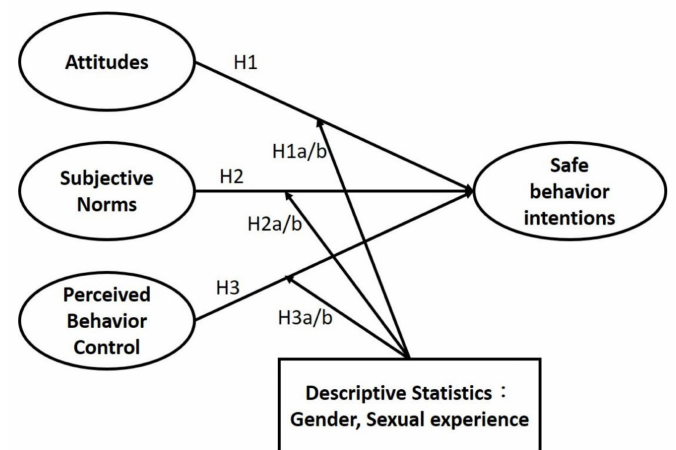
Figure 1. Research